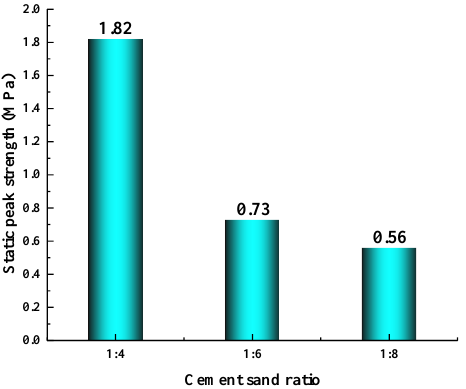
Figure 9. Relationship between cement − sand ratio and static peak strength.